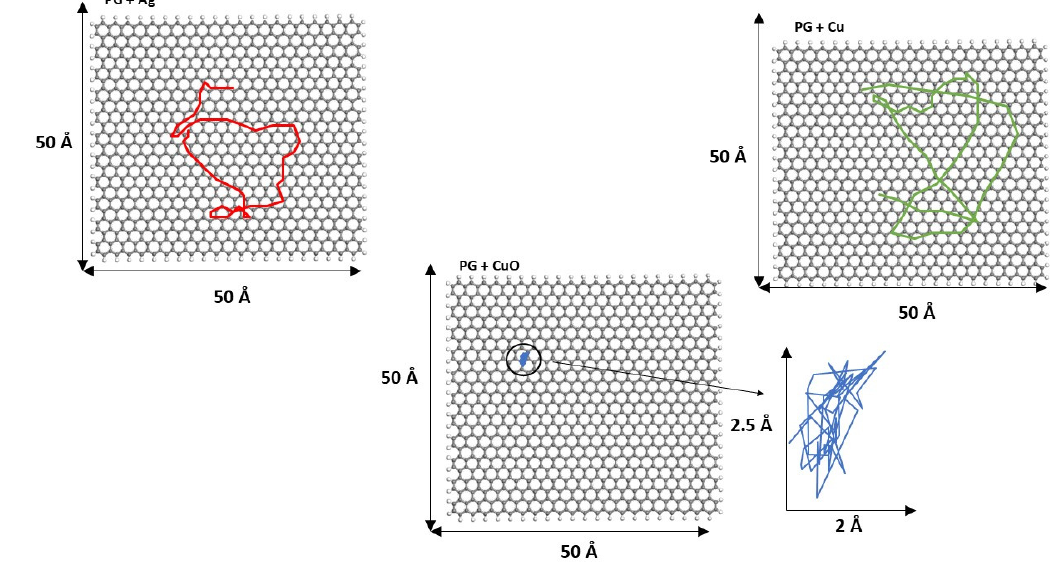
Figure 8. Diffusion trajectories of Ag 13 , Cu 13 , and Cu 6 O 6 over PG during the last 250 ps of simulation length. The diffusion trajectory of the Cu 6 O 6 cluster is magnified for a clearer view.